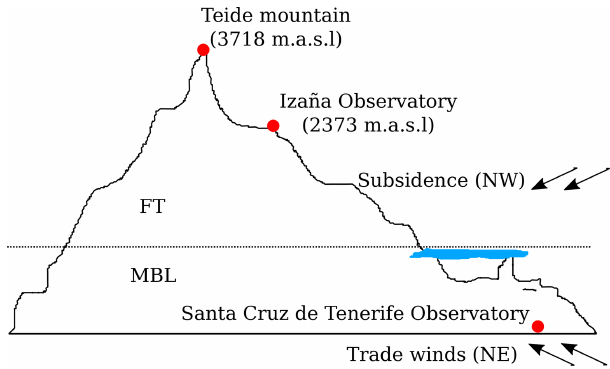
Figure 2. Location of Santa Cruz de Tenerife and Izaña observato- ries on the island of